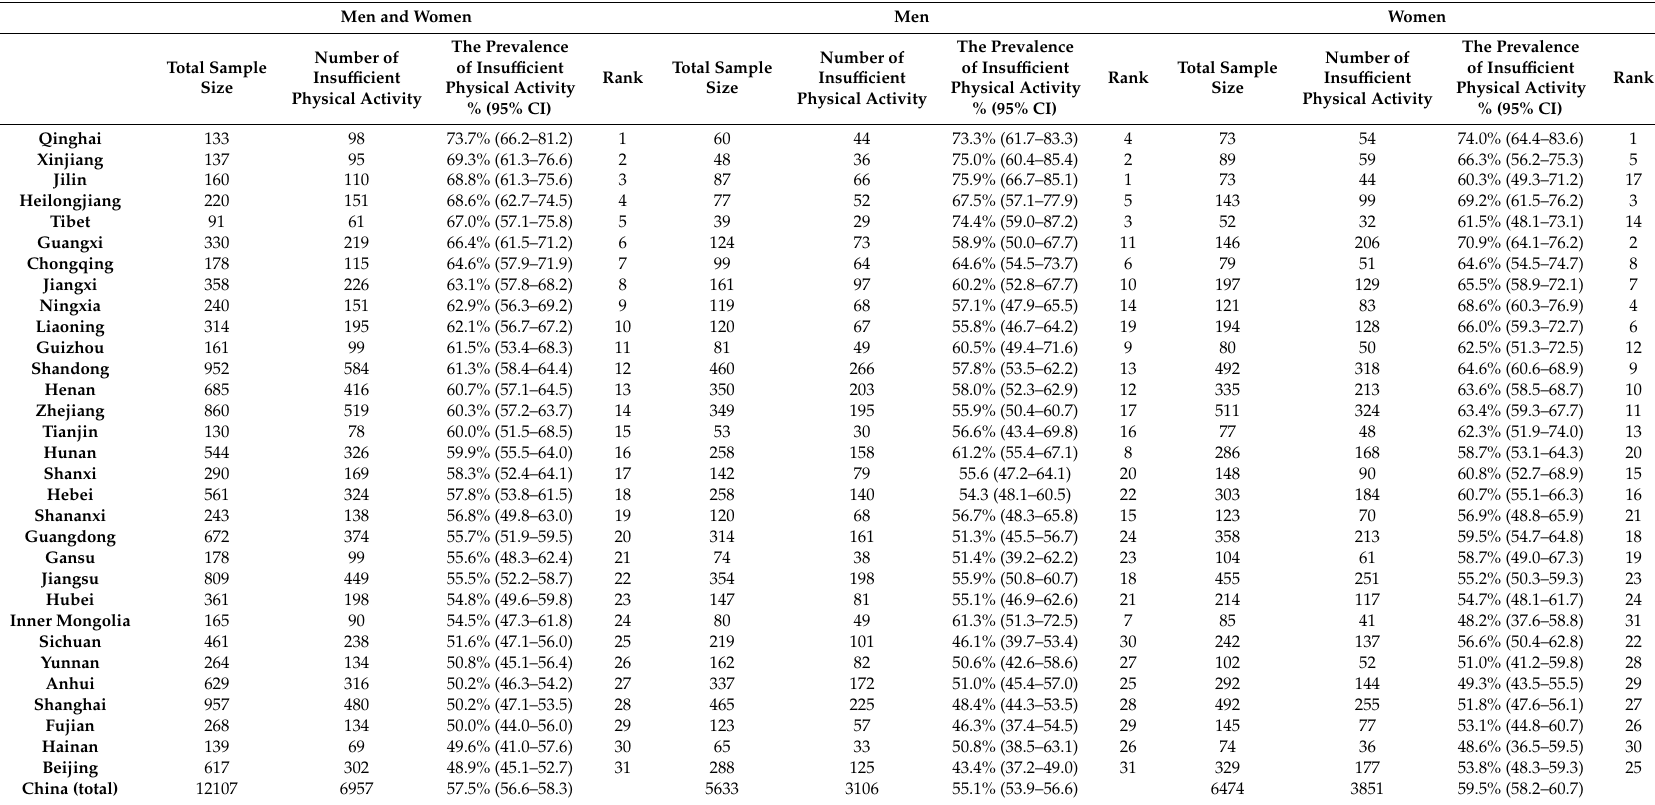
Rank: The ranking of the prevalence of insu ffi cient physical activity in di ff erent